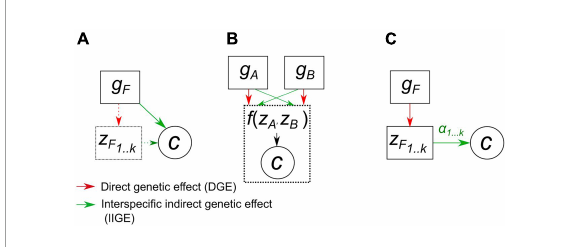
FIGURE2 Causal pathways between genetic effects, g , and a community variable, c , as assumed in the quantitative genetic models described in the main text. (A) IIGE heritability approach: a genetic variance component of a focal species ( g F ) is used to quantify the genetic basis of variation in a community trait. The direct genetic effect on the focal species trait are ignored (dotted line). (B) Joint phenotype approach: the genetic variation of two species is treated symmetrically, considering for each their respective direct and indirect genetic effects. This is a variance component analysis that might either decompose on each species phenotype or directly on the community variable, the joint phenotype, if the two species are harvested together and not sorted. (C) Community-level index for traits: the community variable is regressed on the l traits of the focal species. The regression coefficients are then used to project genetic changes of these traits onto the community variable using a standard linear selection index